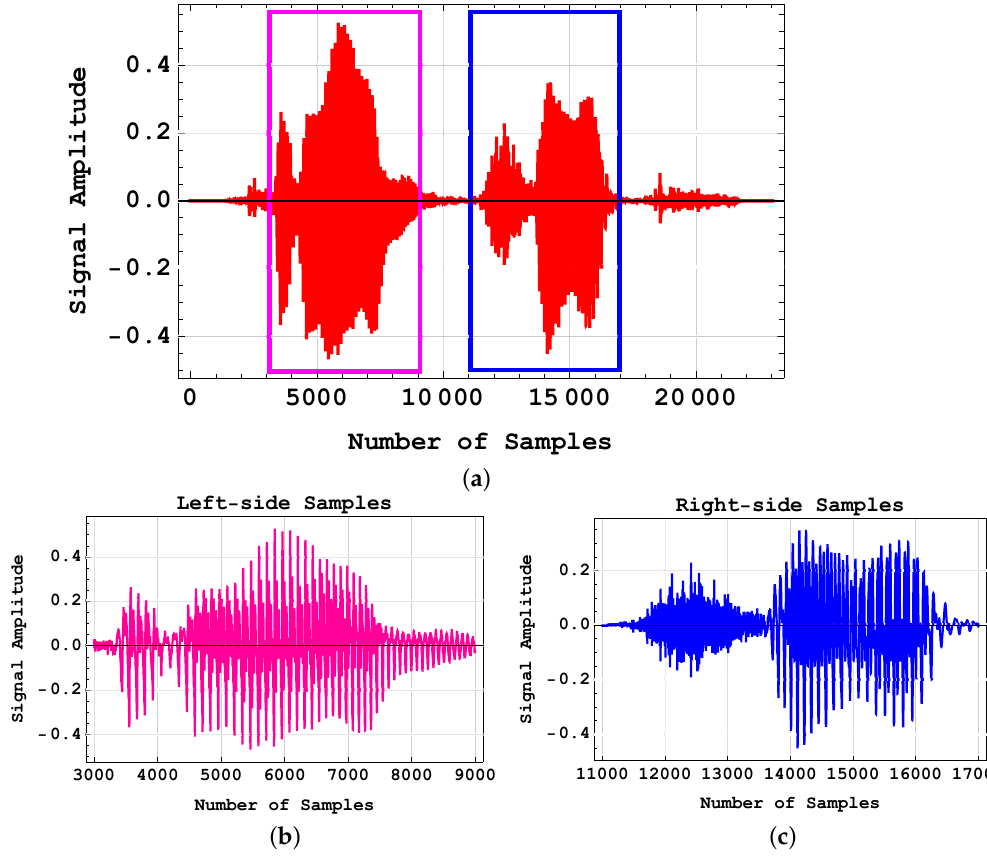
Figure 15. Test speech signal: ( a ) the signal representation of the word ‘Kravchuk’ with 23000 samples, ( b ) the first syllable of this word (‘Krav’), and ( c ) the second syllable of this word